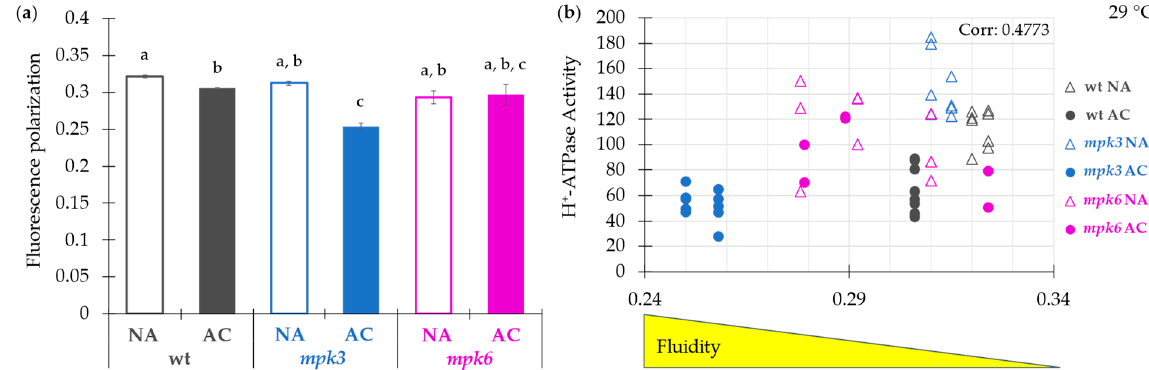
Figure 5. Effect of cold acclimation on the plasma membrane fluidity in wild type, mpk3, and mpk6 plants. Membrane fluidity of was measured by fluorescence polarization (FP) of the fluorescent probe 1-(4-trimethylammoniumphenyl)-6-phenyl-1,3,5-hexatriene p -toluenesulfonate (TMA-DPH) at excitation and emission wavelengths, respectively, of 340 nm/417 nm. PMV (300 µg of protein) isolated from Arabidopsis thaliana leaves exposed to NA or AC conditions were added to the assay medium and steady-state fluorescence polarization was recorded at 29 °C. Values presented in panel ( a ) are means from 20 to 30 recordings, from two to three independent biological samples ± SE. α ≤ 0.05 (ANOVA test). ( b ) Correlation plot between H + -ATPase activity and FP. This was calculated with values from panel ( a ) and Figure 2a using the Pearson model.